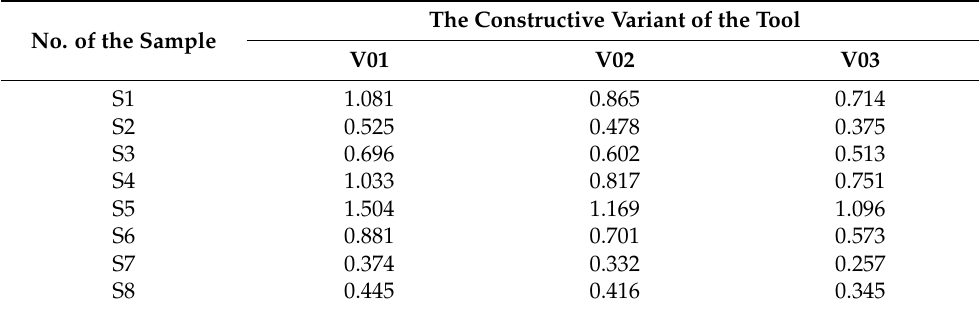
Table 7. The medium values of the power, P , for the 3 variants of cutting tools, kW.